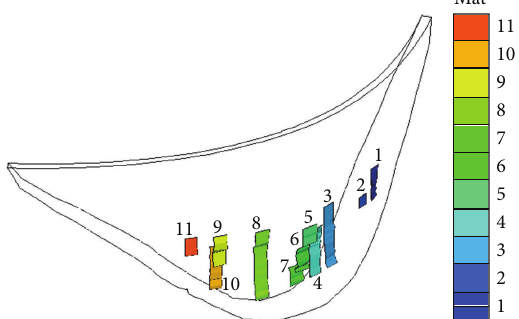
Figure 11: Distribution of cracks in the